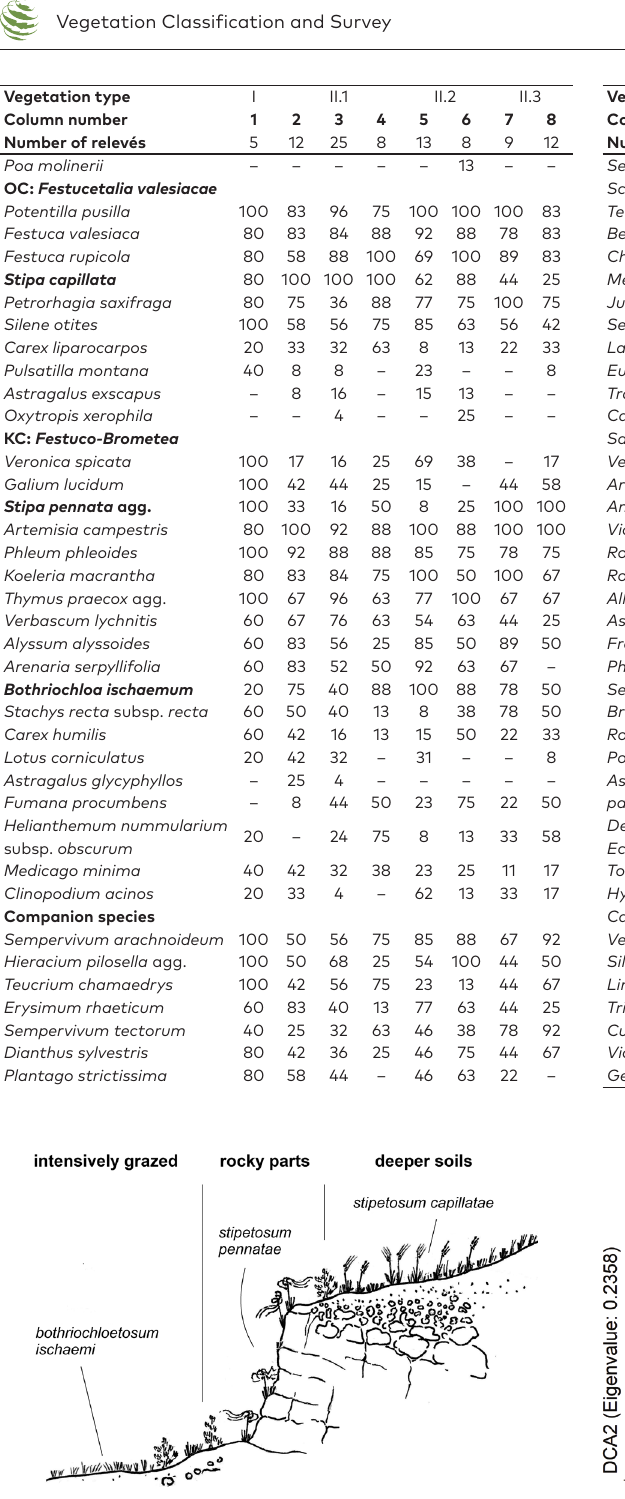
Figure 4. Idealised scheme of the ecological occurrence